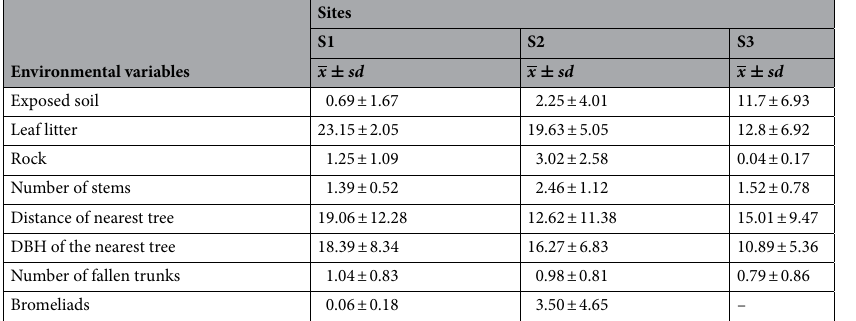
Table 1. Environmental variables estimated at three study sites at Grota do Angico Natural Monument (GANM), Sergipe, Brazil. Values correspond to the mean ± SD of data collected for 32 quadrat frames in each site (spread along a 5-km-long transect with a minimum distance of 2 km between them). DBH diameter at breast height of nearest tree. For information on the three sites see